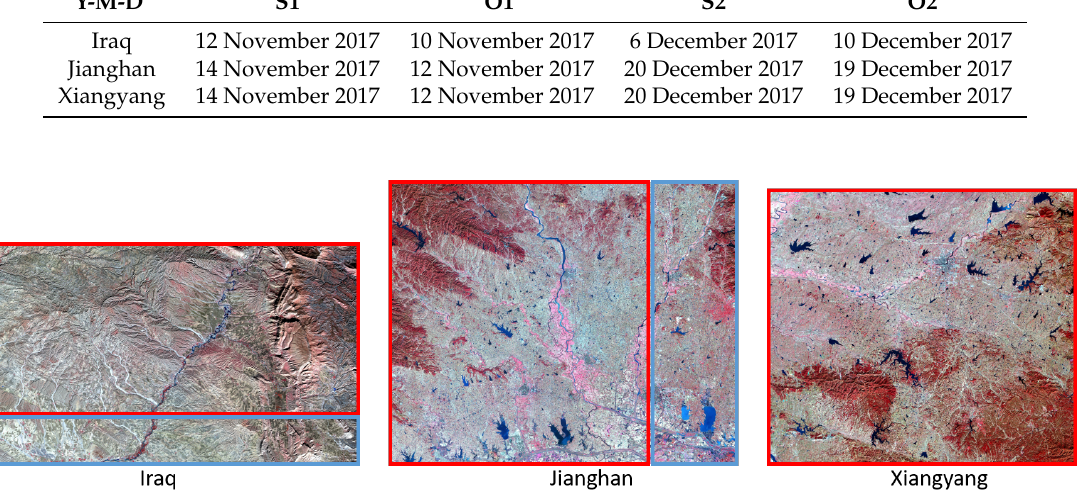
Table 1. Sensing time of optical and SAR image pairs used in the experiments. Y-M-D S1 O1 O2 Iraq